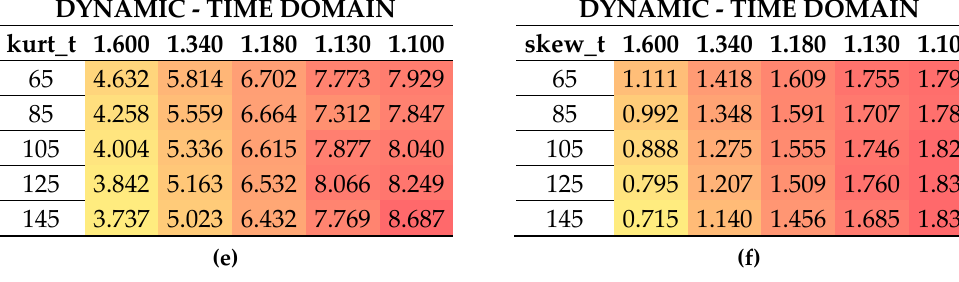
Figure 10. Kurtosis and skewness of surge motion (a)(b) , heave motion (c)(d) and most loaded line tension (e)(f) obtained with the DynTD approach.